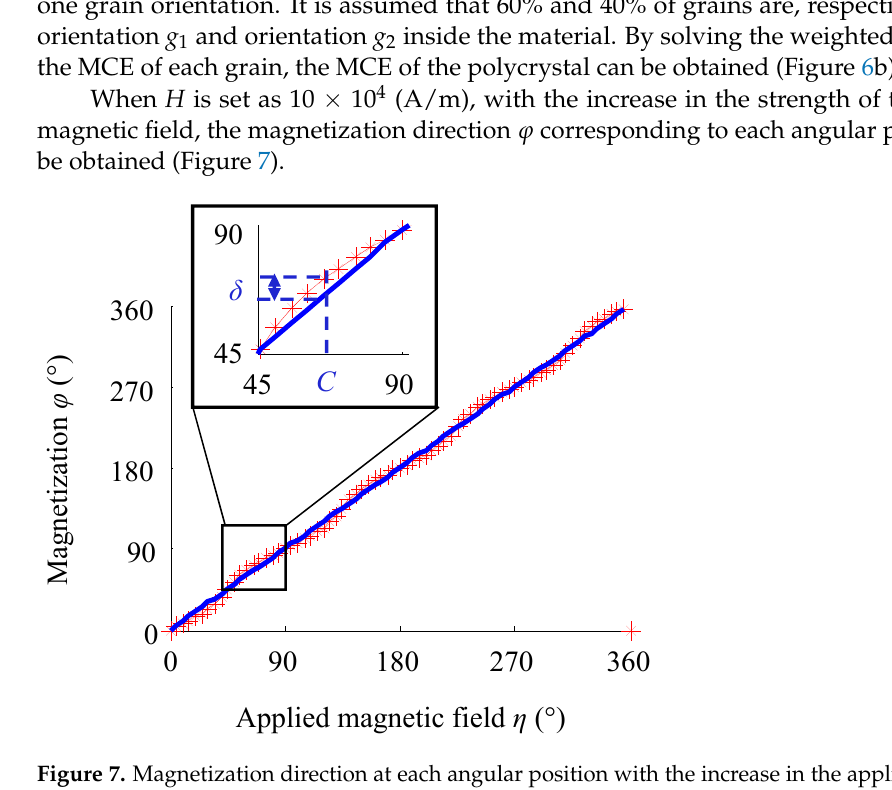
Figure 7. Magnetization direction at each angular position with the increase in the applied magnetic field strength.